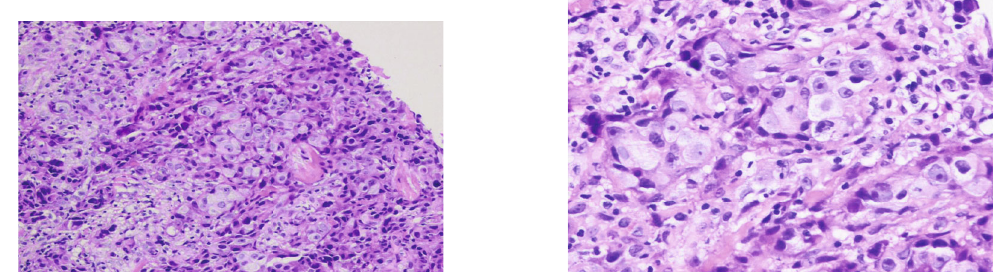
Figure 4: (a, b) Histological characteristics of HR+/HER2- group (CNB, × 20 and × 40).